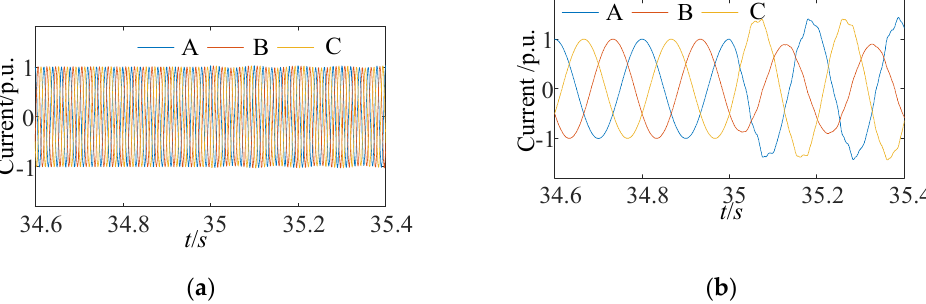
Figure 2. Three-phase currents of stator side and rotor side: ( a ) stator side; ( b ) rotor side.